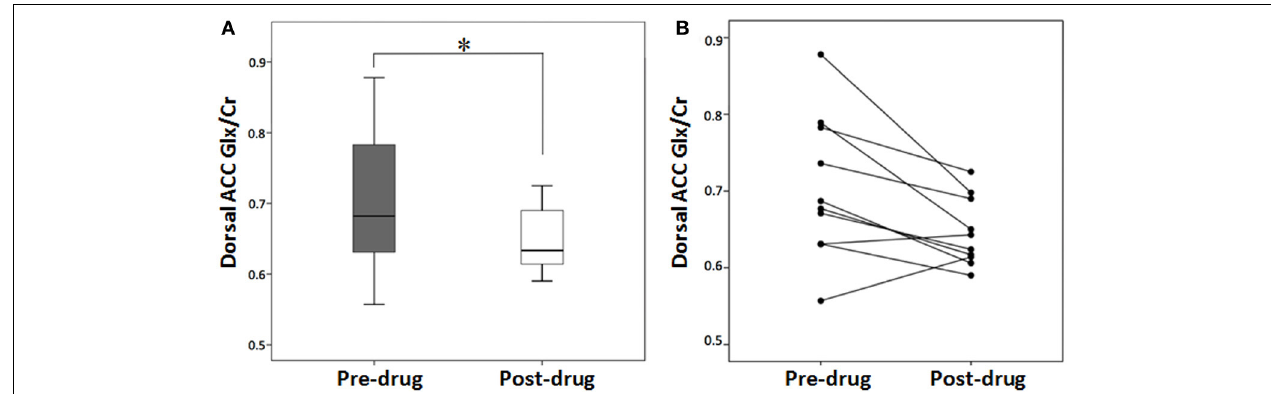
FIGURE 1 | Dorsal anterior cingulate (dACC), glutamate + glutamine (Glx)/creatine (Cr), baseline (pre-drug), and at week 12 (post-drug) for study completers. (A) Box plot of median Glx/Cr in the dACC at